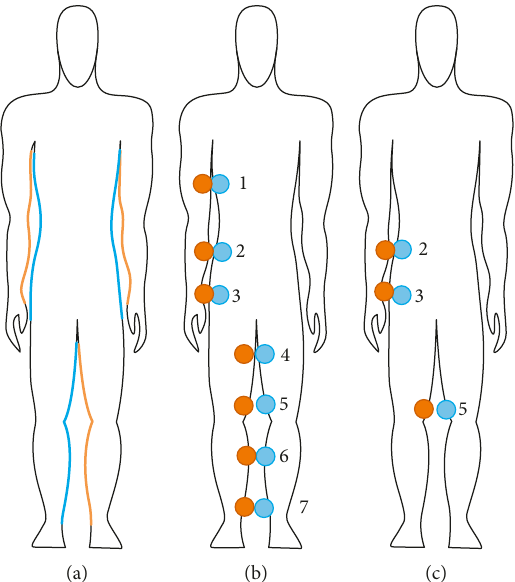
Figure 4: Location of the individual parts of the electromagnetic generator: (a) possible areas of application, (b) primary test locations, (c) selected locations of retesting (reproduced from Terlecka et al. [13], under the Creative Commons Attribution License/public